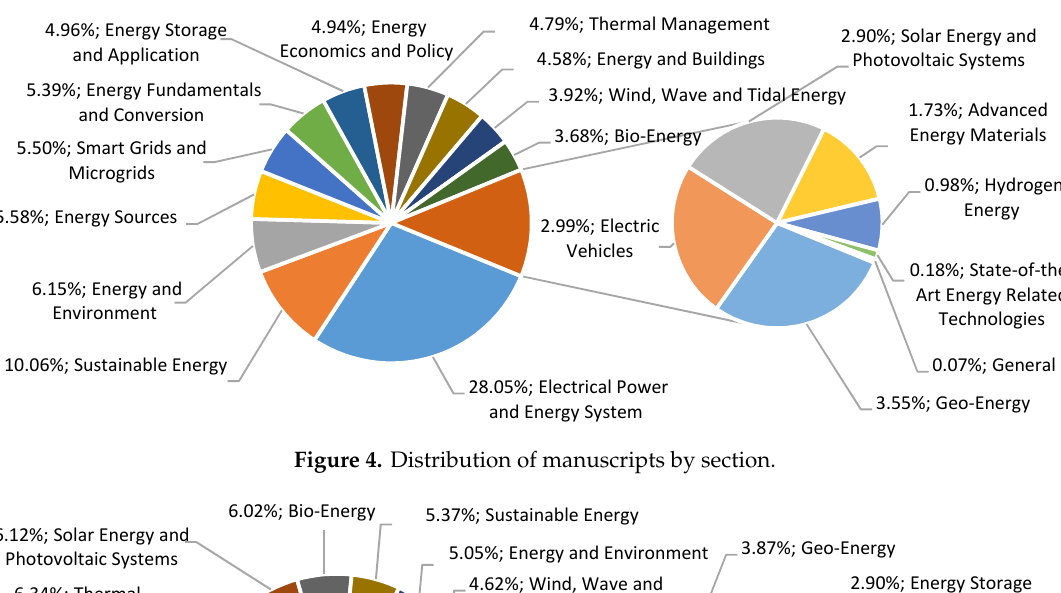
Figure 3. Evolution of number of publications in MDPI’s Energies journal.